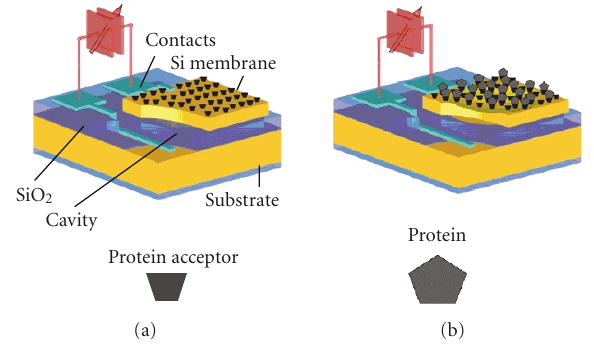
Figure 1: Hybridization process using capacitive